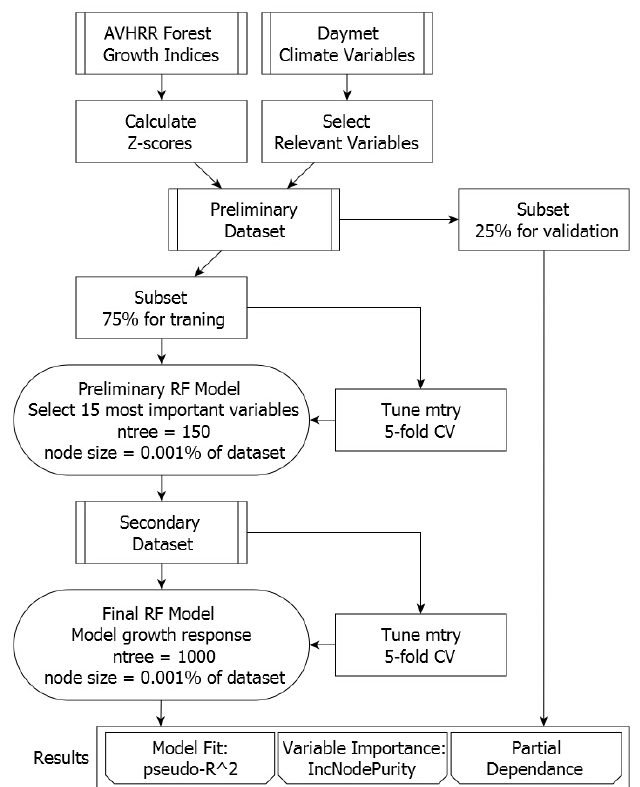
Figure 2. Flowchart of major steps in the forest-climate modelling workflow. This procedure was performed four times, once for each forest growth index. Inputs were AVHRR forest growth indices (the dependent variable) and pre-processed Daymet climatological data (the independent